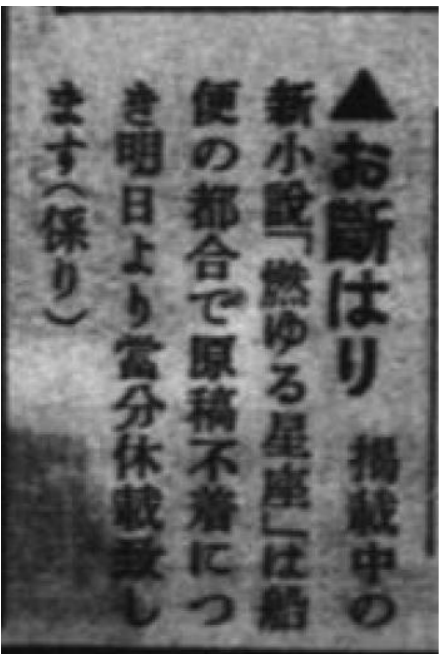
Figure 7. Announcement about delayed receipt of Constellations Ablaze . Kashū mainichi shinbun 8 March 1938. Image courtesy of the Hoji Shinbun Digital Collection.